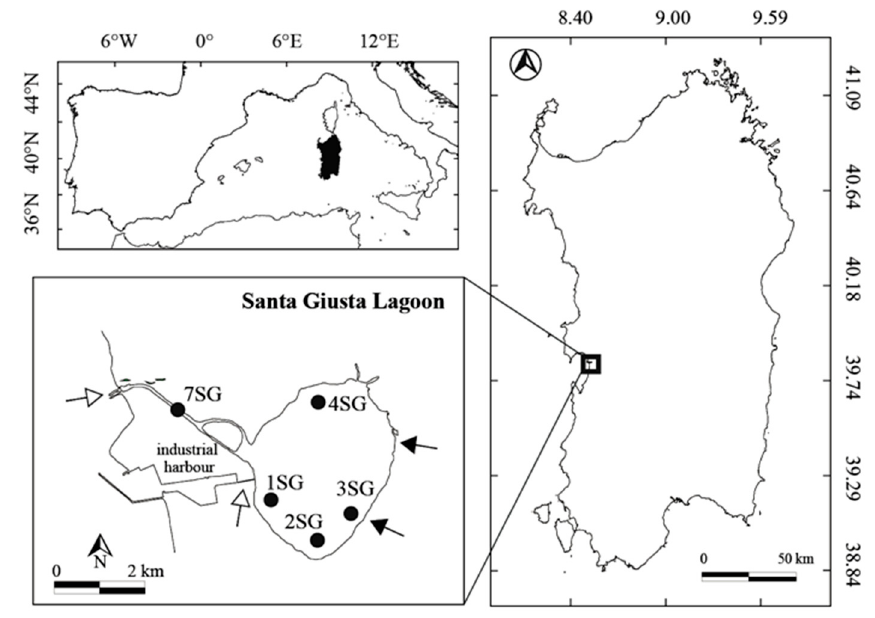
Figure 1. Study area and location of water sampling stations. Black arrows: freshwater inputs; white arrows: marine inlets.